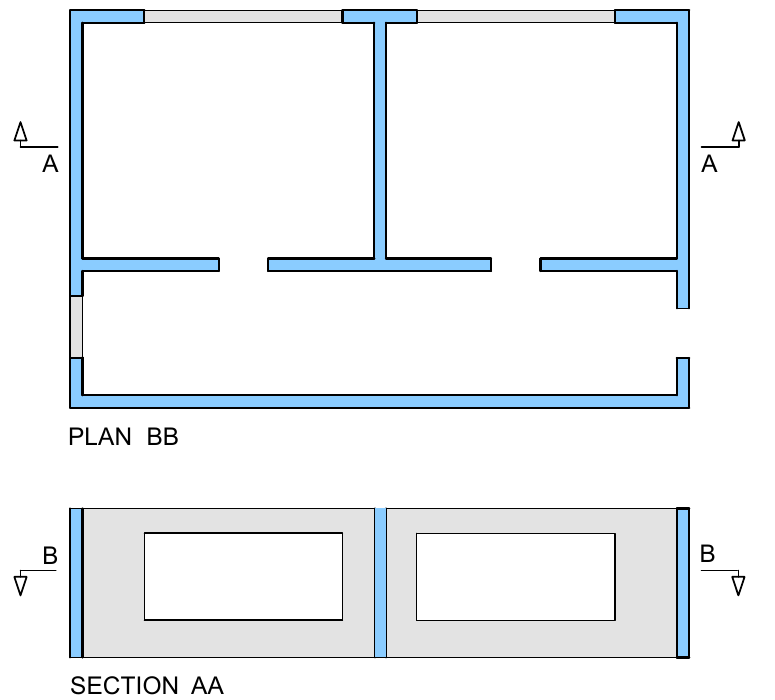
Figure 1. Line drawings showing a plan and a section of a building.